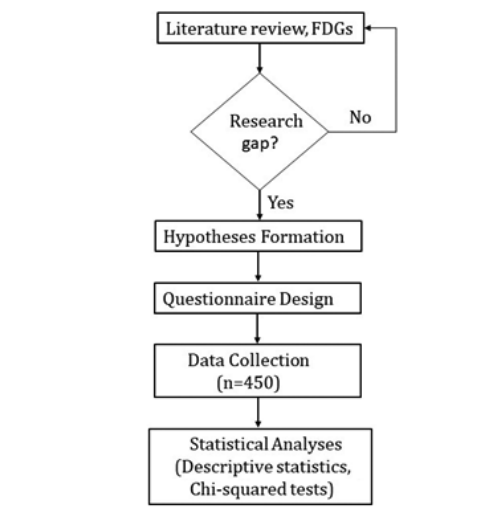
Figure 1. Research